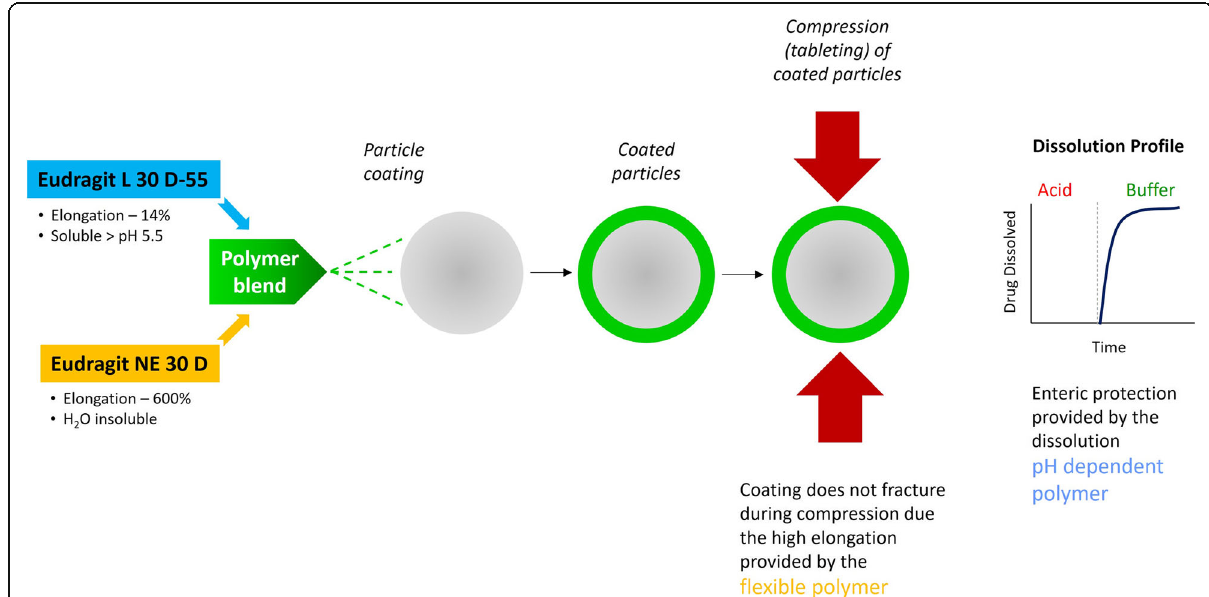
Fig. 4 Illustration of the use of an Eudragit® L30D-55 and Eudragit® NE30D polymer blend to prepare flexible enteric film coatings that can be compressed without undergoing